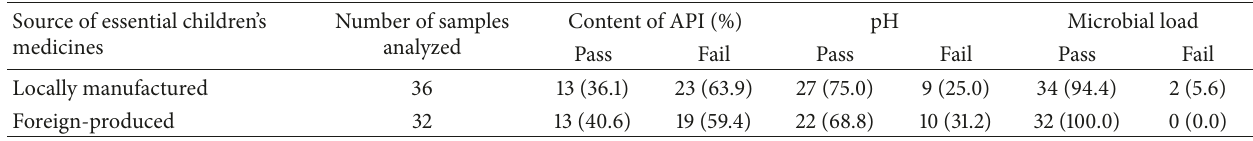
Table 4: Summary results of the quality of locally manufactured and foreign (imported) essential children’s medicines investigated. Source of essential children’s